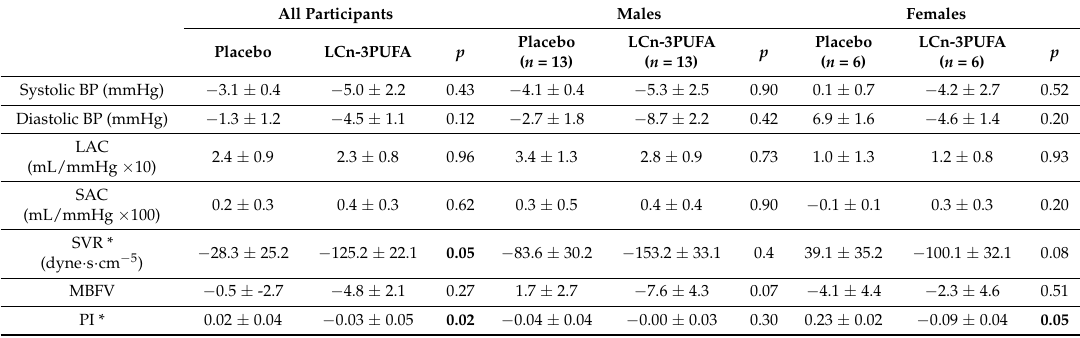
Table 2. Treatment differences in measures of arterial function for placebo and LCn-3PUFA